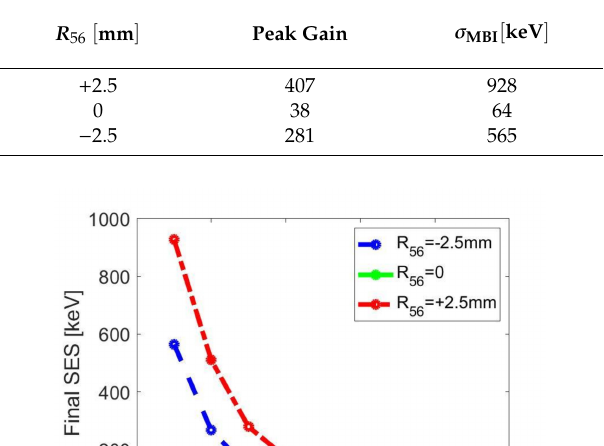
Figure 1. From left to right are the final energy modulation, bunching factor, and gain as a function of the initial modulation wavelength λ 0 . For the longitudinal transport matrix term R 56 = –2.5 mm ( top ), 0 ( middle ), and + 2.5 mm ( bottom ), respectively. We note the di ff erent scales used for the three cases. Table 3. The calculated peak gain and final slice energy spread (SES, also σ MBI in the text) for the three values of the longitudinal transport matrix term R 56 of the switchyard for 1 GeV beam energy and 10 keV initial energy spread.